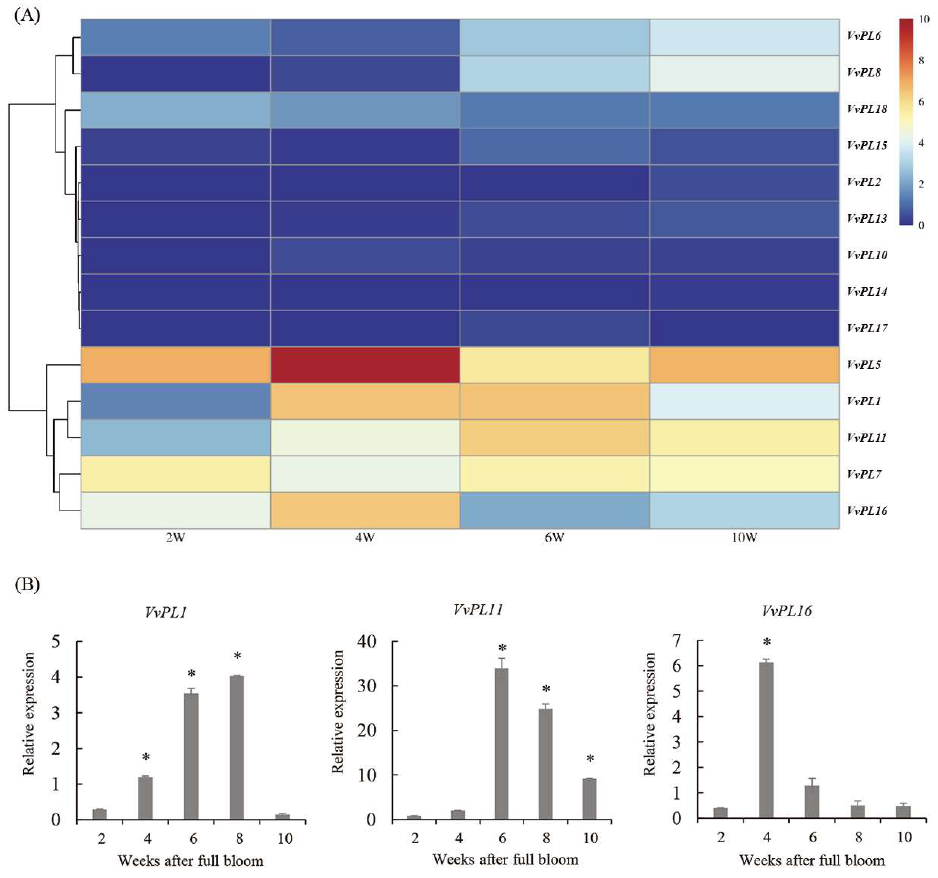
Figure 5. Expression patterns of VvPL genes at different fruit developmental stages of ‘Hanxiangmi’. ( A ) Expression heatmap of VvPL genes from the transcriptomes of grape berries at different devel- opmental stages. The color scale on the right represents the RPKM normalized log 2 . Blue indicates low expression levels, yellow indicates moderate expression levels, and red indicates high levels. ( B ) Relative expression levels of VvPL genes verified by RT-qPCR in developing fruit at 2, 4, 6, 8, and 10 weeks after full bloom (2 W, 4 W, 6 W, 8 W, and 10 W). Data were shown as the means ± standard deviation. * represent significant differences at p < 0.05.